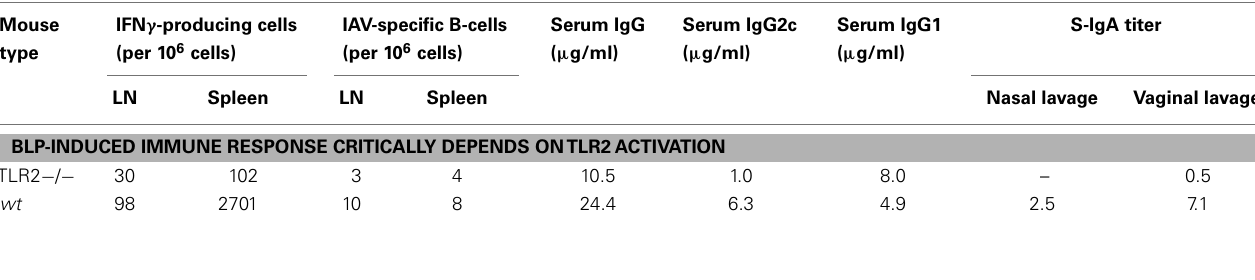
Table 3 | Immunostimulatory capacity of BLPs in vivo critically depends onTLR2 activation. Mouse